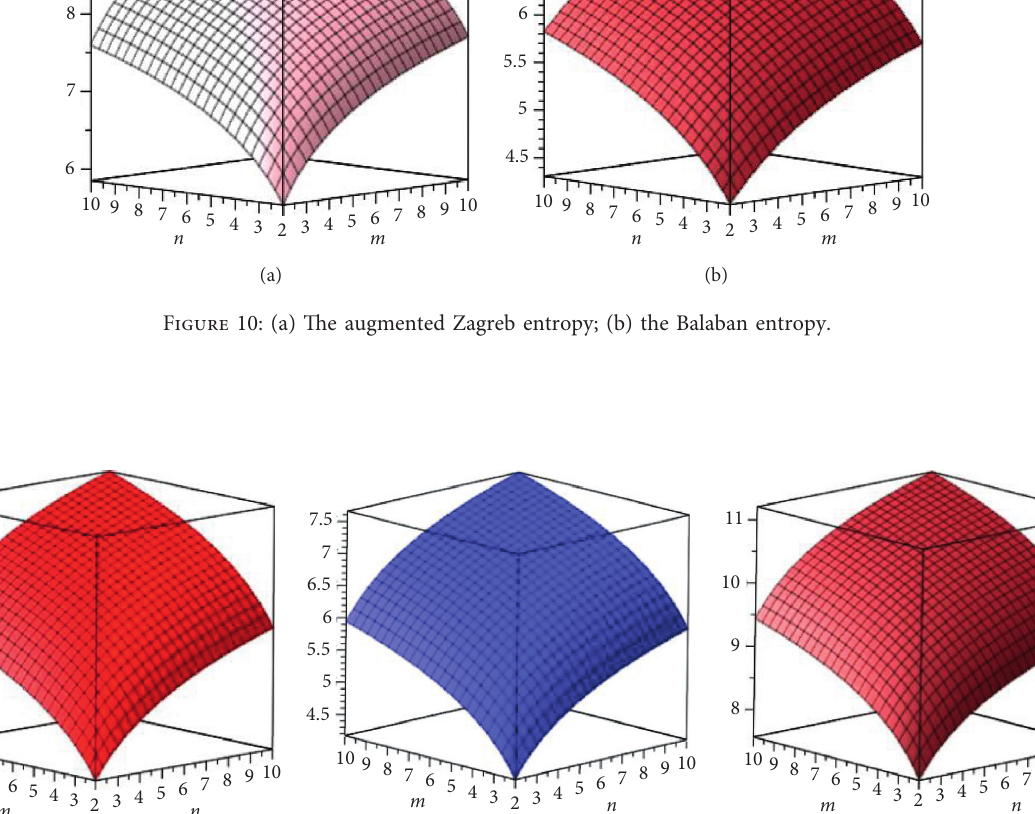
entropy; (b) the GA 4